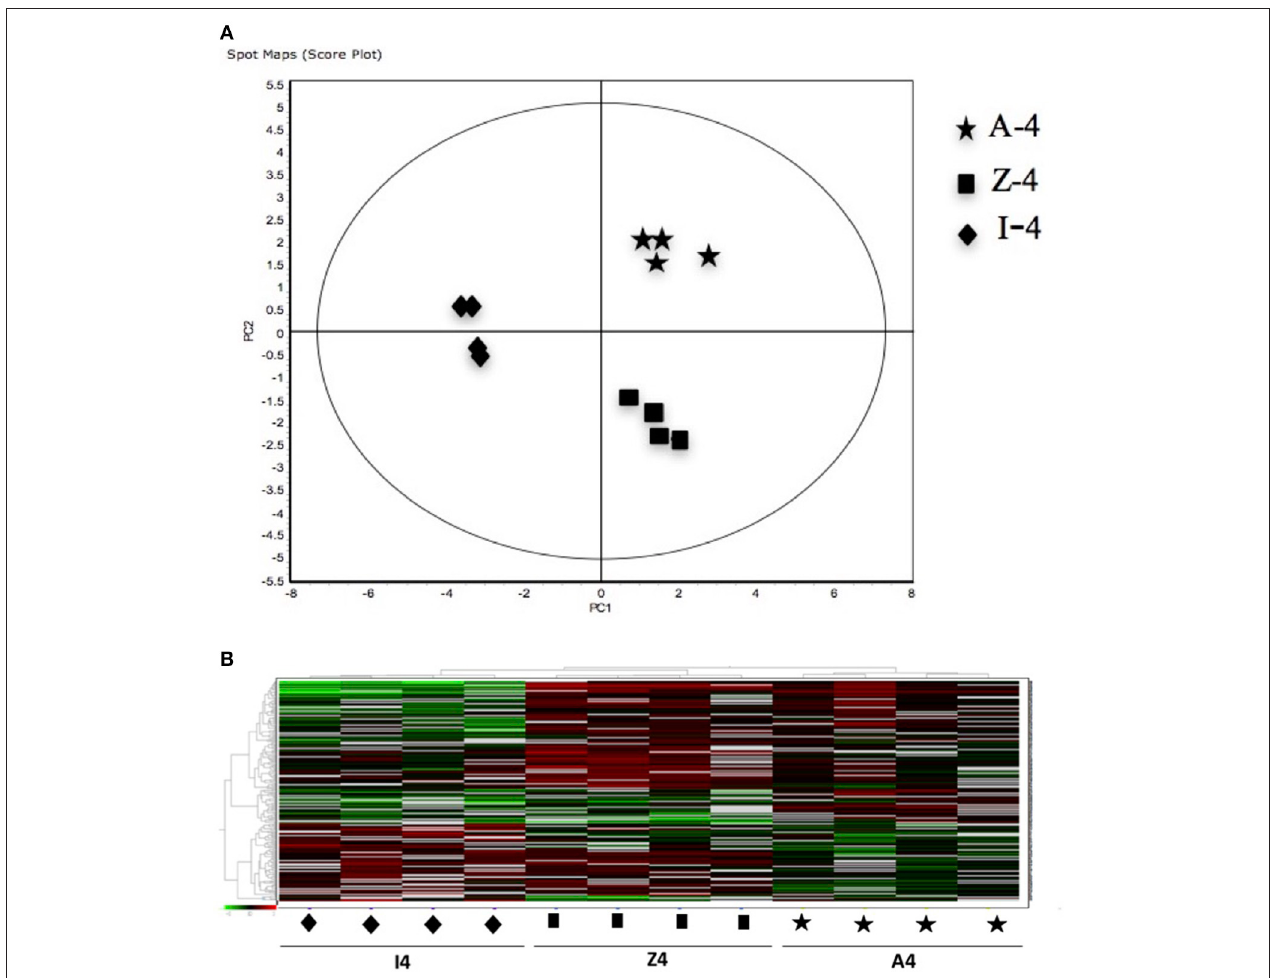
FIGURE 3 | (A) Principal Component Analyses (PCA) and (B) hierarchical cluster analyses of the protein spots (sub-sets) differentially expressed of paralarvae of Octopus vulgaris corresponding to the condition 2 (A4, Z4 vs. I4) considered as function of dietary group and age (details in Supplementary Table 3). % of variance explained: PC1 = 73.7; PC2 =